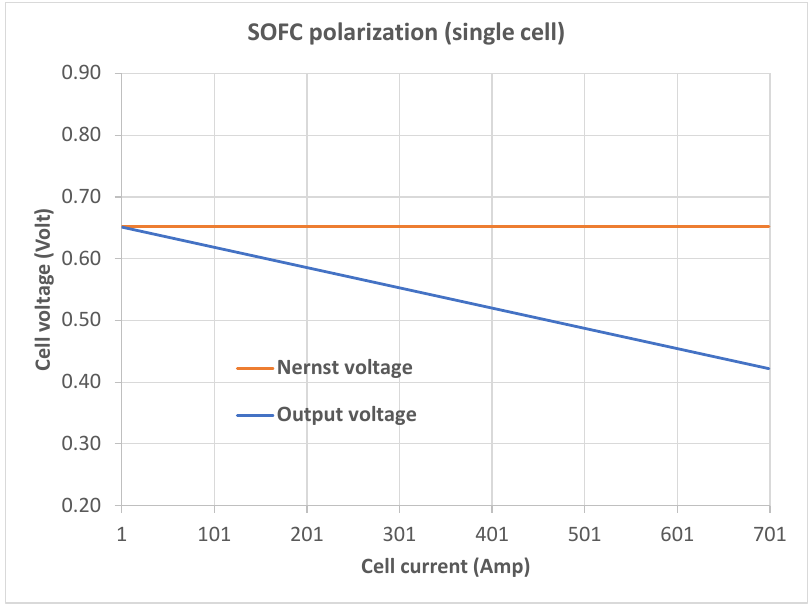
Figure 2. SOFC polarization obtained with E Nernst = 0.651473